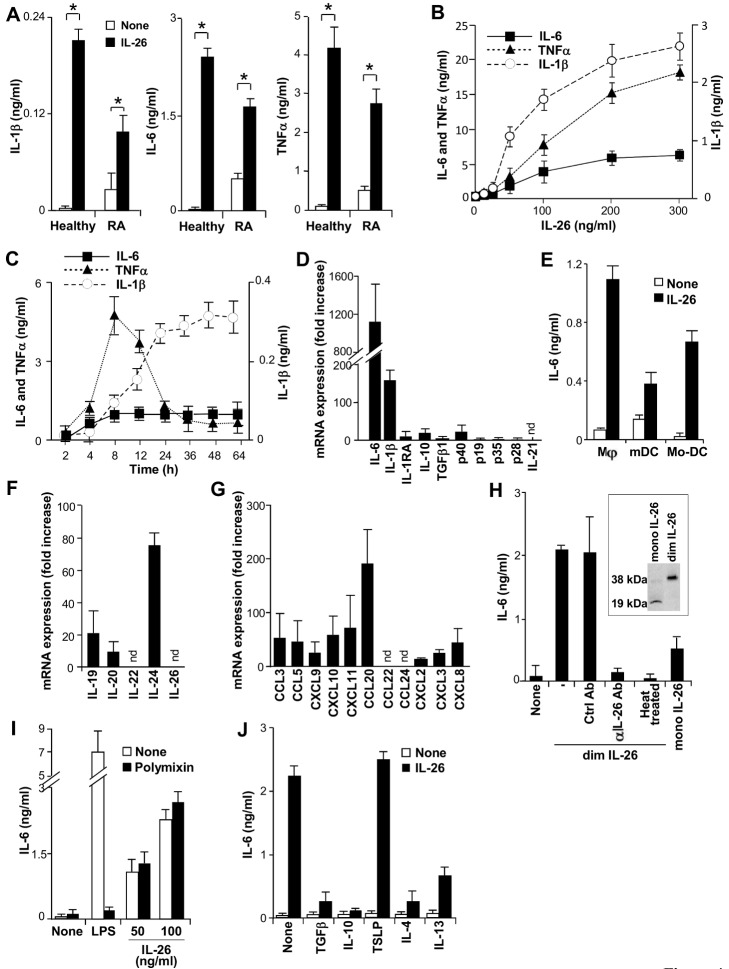
IL-26 upregulates proinflammatory cytokine secretion by myeloid cells.(A) IL-1-beta, IL-6, and TNF-alpha were quantified by ELISA in the 16 h (IL-6 and TNF-alpha) or 48 h (IL-1-beta) supernatants of monocytes isolated from the blood of healthy subjects or CD14+ myeloid cells isolated from RA SF cells and exposed or not to 50 ng/ml IL-26. (B) Monocytes were exposed to increasing concentrations of IL-26. IL-1-beta, IL-6, and TNF-alpha were quantified by ELISA in the 16 h (IL-6 and TNF-alpha) or 48 h (IL-1-beta) supernatants. (C) Monocytes were exposed to 50 ng/ml IL-26 and IL-1-beta, IL-6, and TNF-alpha were quantified by ELISA in the supernatants collected at the indicated time-points. (D) Monocytes were exposed to 50 ng/ml IL-26 for 6 h and the expression of the mRNA encoding the indicated cytokines was analyzed by RT-qPCR. Results are expressed in fold increase of mRNA expression compared to unstimulated cells (mean ± SD, n = 3); nd, means not detectable. TNF-alpha mRNA expression, measured after 2 h stimulation [55], was increased of 15 fold (unpublished data). (E) Monocyte-derived macrophages (MΦ), BDCA1+ peripheral blood myeloid dendritic cells (mDC), and monocyte-derived DC (Mo-DC) were cultured without or with 50 ng/ml dimeric IL-26. IL-6 was quantified by ELISA in the 16 h supernatants. (F–G), Monocytes were exposed for 6 h to 50 ng/ml dimeric IL-26 (dim IL-26) and the mRNA encoding members of the IL-10 cytokine family (F) and chemokines (G) were analyzed by RT-qPCR. Results are expressed in fold increase of mRNA expression, compared to unstimulated cells. (H) Monocytes were cultured in the presence of 50 ng/ml IL-26, 50 ng/ml IL-26 plus 10 µg/ml neutralizing goat anti-IL-26 Ab or a control Ab, 50 ng/ml heat-treated IL-26, or 50 ng/ml monomeric IL-26 (mono IL-26). Insert, Western-blotting analysis of monomeric and dimeric IL-26. (I) Monocytes were cultured in the presence of 50 or 100 ng/ml IL-26 or 100 pg/ml LPS, with or without 0.2 µg/ml polymixin B. (J) Monocytes were cultured in the presence or absence of 50 ng/ml IL-26, with or without 20 ng/ml IL-4, IL-10, IL-13, TGF-beta, or TSLP. (H–J) IL-6 was quantified in the 16 h supernatants. (A–C, E, H–J) Results are expressed in ng/ml (mean ± SD, n = 5). * p<0.05 (Wilcoxon matched-pairs signed-ranks test).